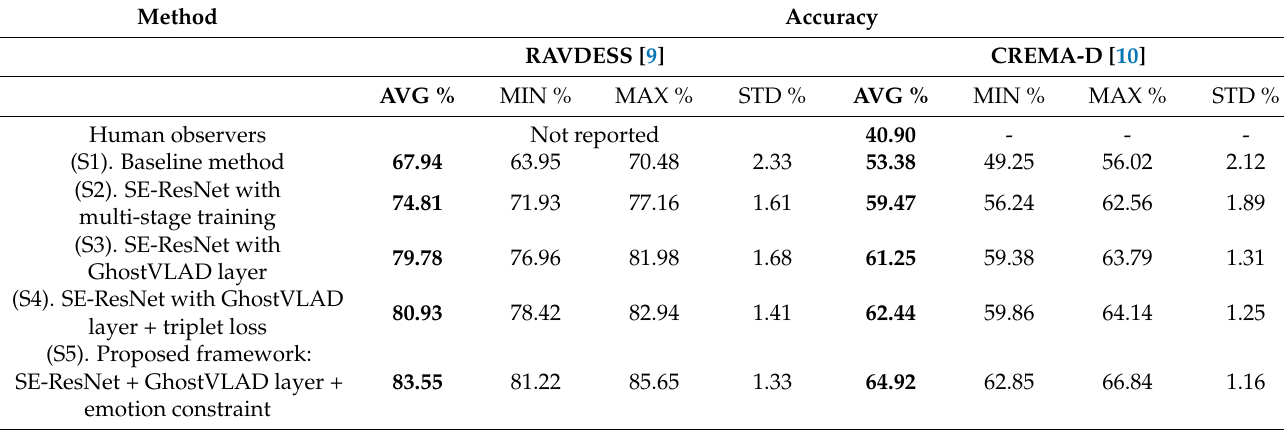
Table 2. The experimental results presenting the influence of each component over the emotion recognition framework.